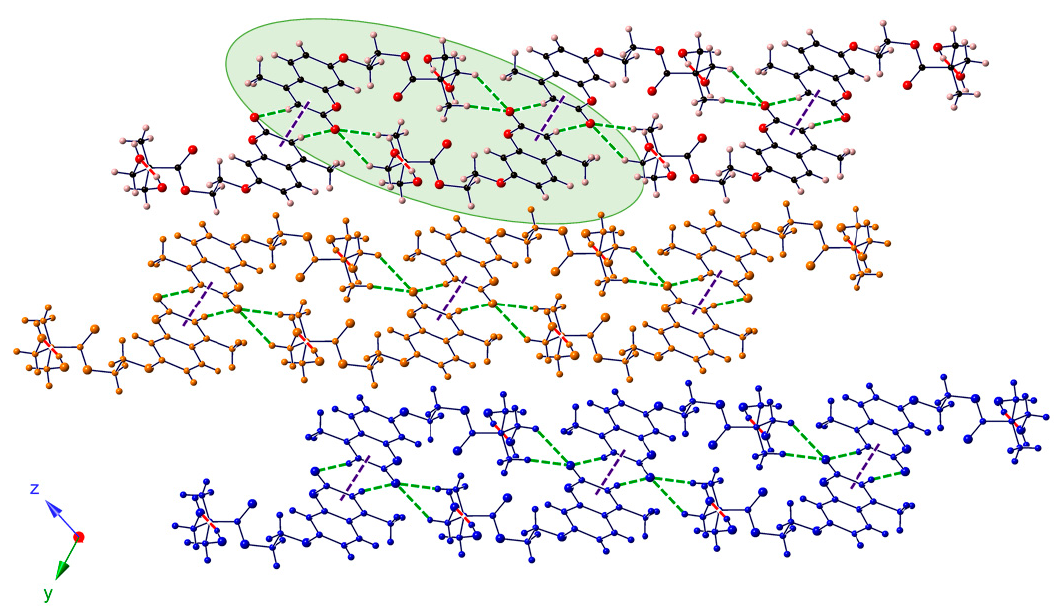
Figure 10. View of the crystal packing of DHEOMC along the crystallographic X axis indicating its bidimensional character. Hydrogen-bonded double-chains are highlighted in green.